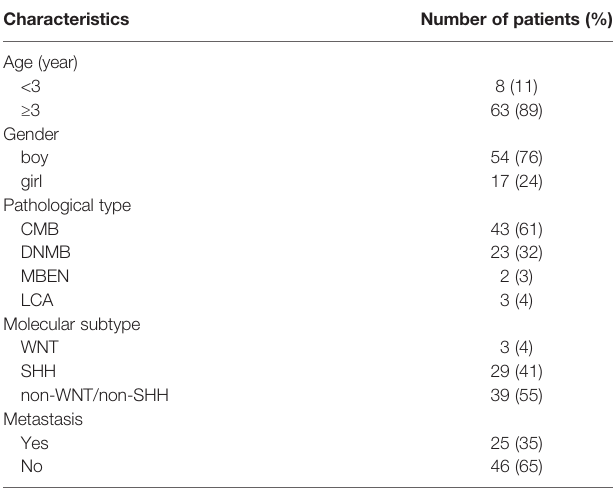
TABLE 1 | Clinical characteristics of medulloblastoma patients.